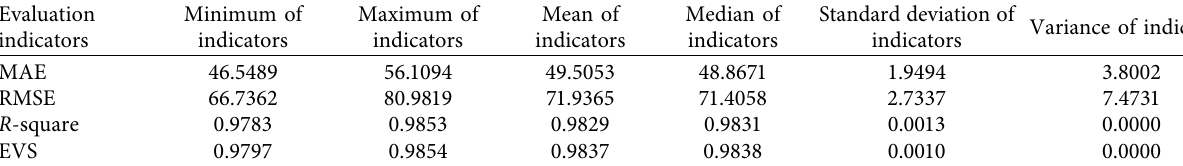
Table 6: Predictive performance evaluation profiles of LHV for the testing phase by LHV-SIX.